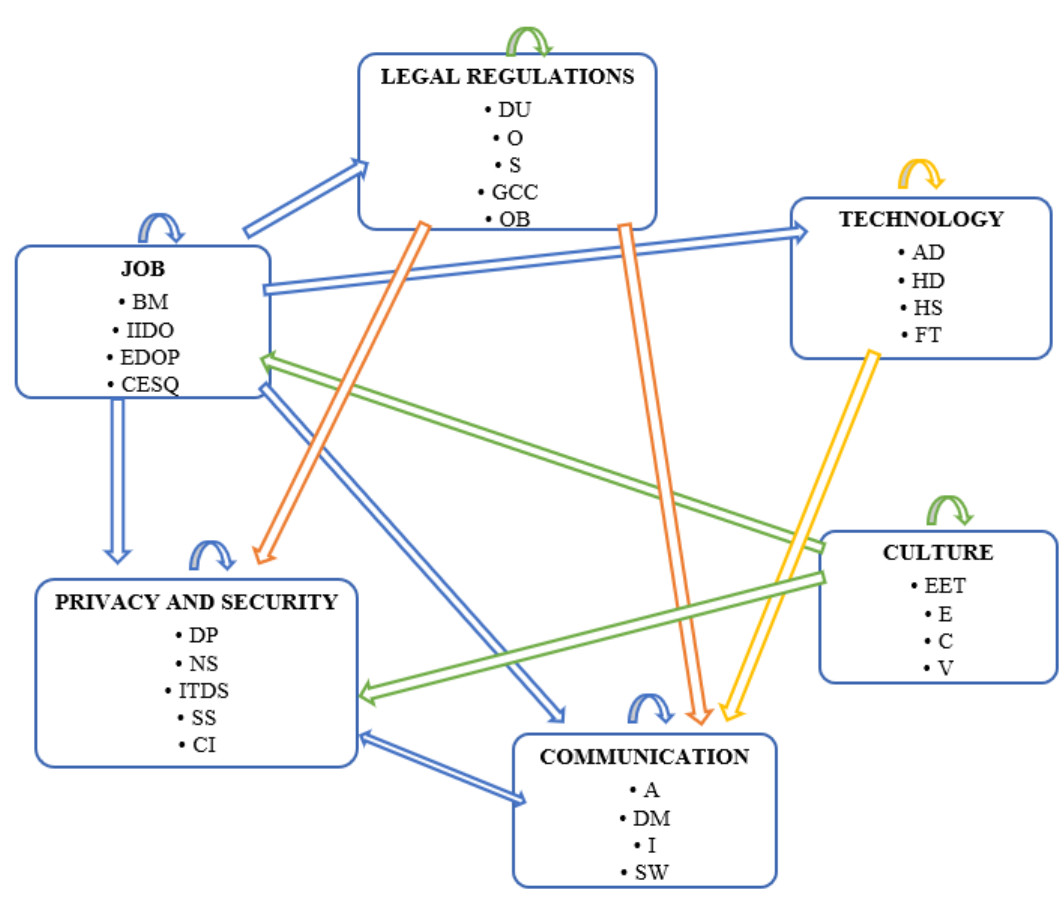
Figure 3. Network Figure 3. Network structure .